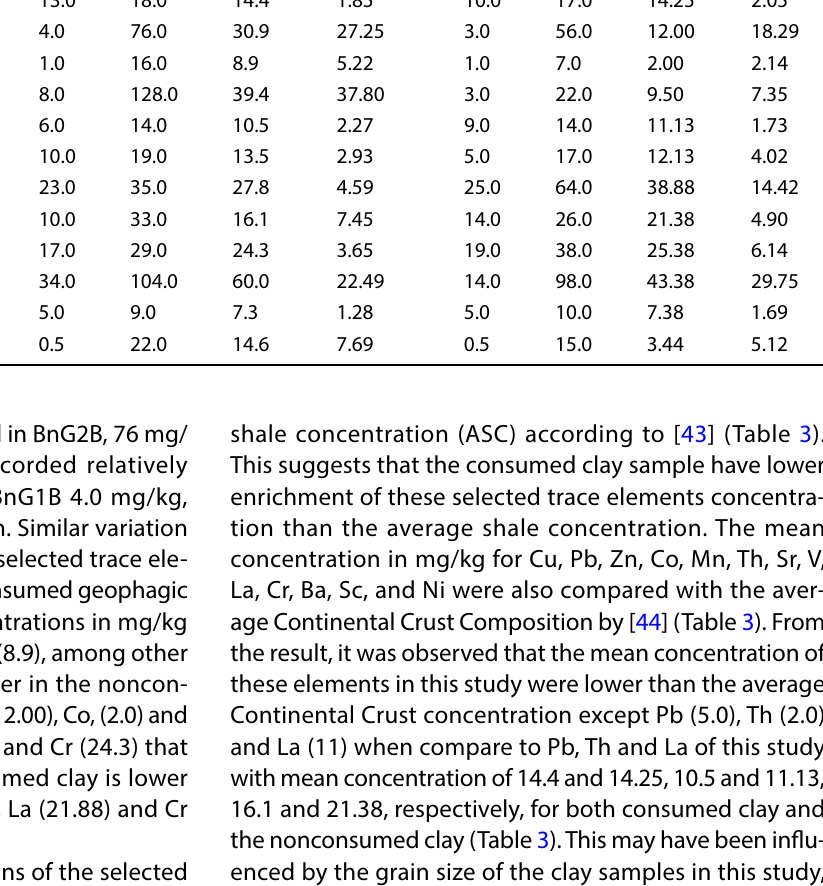
Table 2 Trace elements compositions of the geophagic clay in the study area in mg/kg